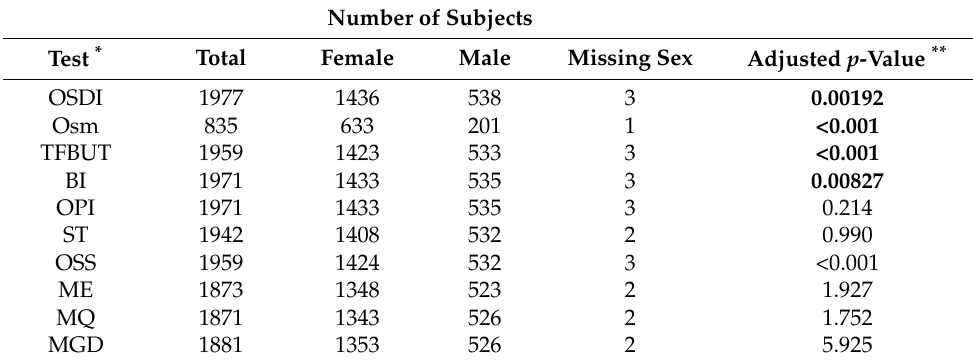
Table 1. Test characteristics: overview of sample size for each test, out of 2094 recruited